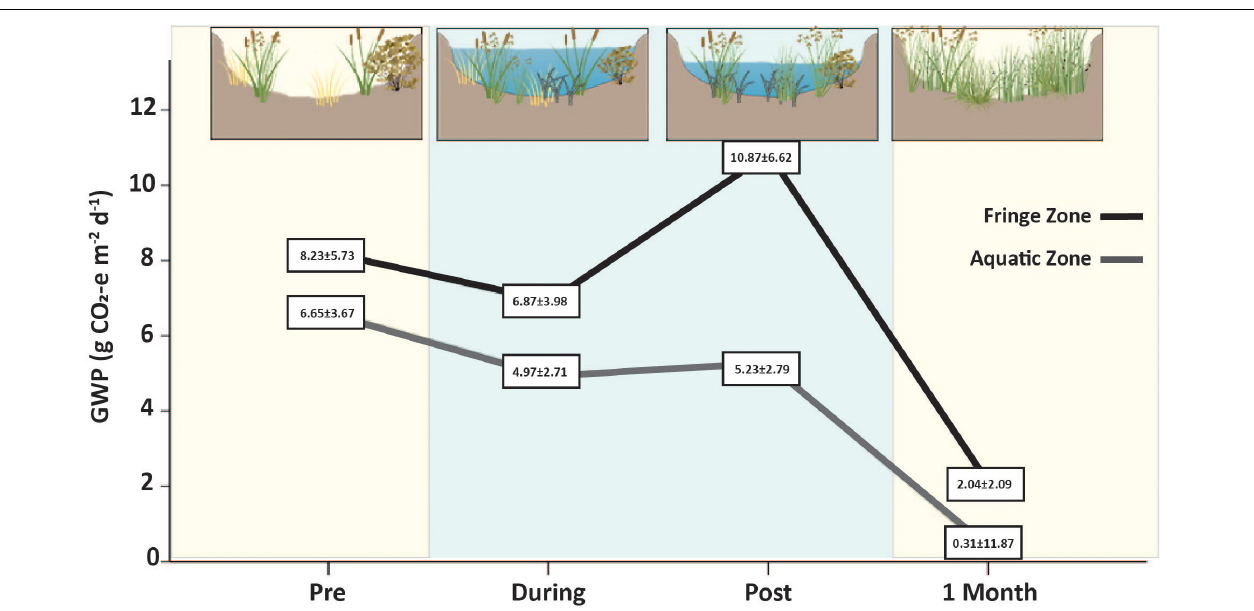
FIGURE 6 | Total carbon emissions/global warming potential (CO 2 + CH 4 g CO 2 -e m − 2 day − 1 ) before (Pre), during (During and Post), and after watering (1 Month). Blue panels signify the presence of water in the wetland ecosystem whereas yellow panels indicate that no water was present at that time. Carbon emissions were 84% lower in the Aquatic Zone (gray line) compared to the Fringe Zone (black line) after the entire watering event. The lower emissions across the entire watering event could be correlated with presence of water in the During and Post phases which altered microbial composition and subsequent carbon emissions in the degraded wetland ecosystem. Higher vegetative growth in the Aquatic Zone compared to the Fringe Zone may have influenced the lower carbon emissions at this